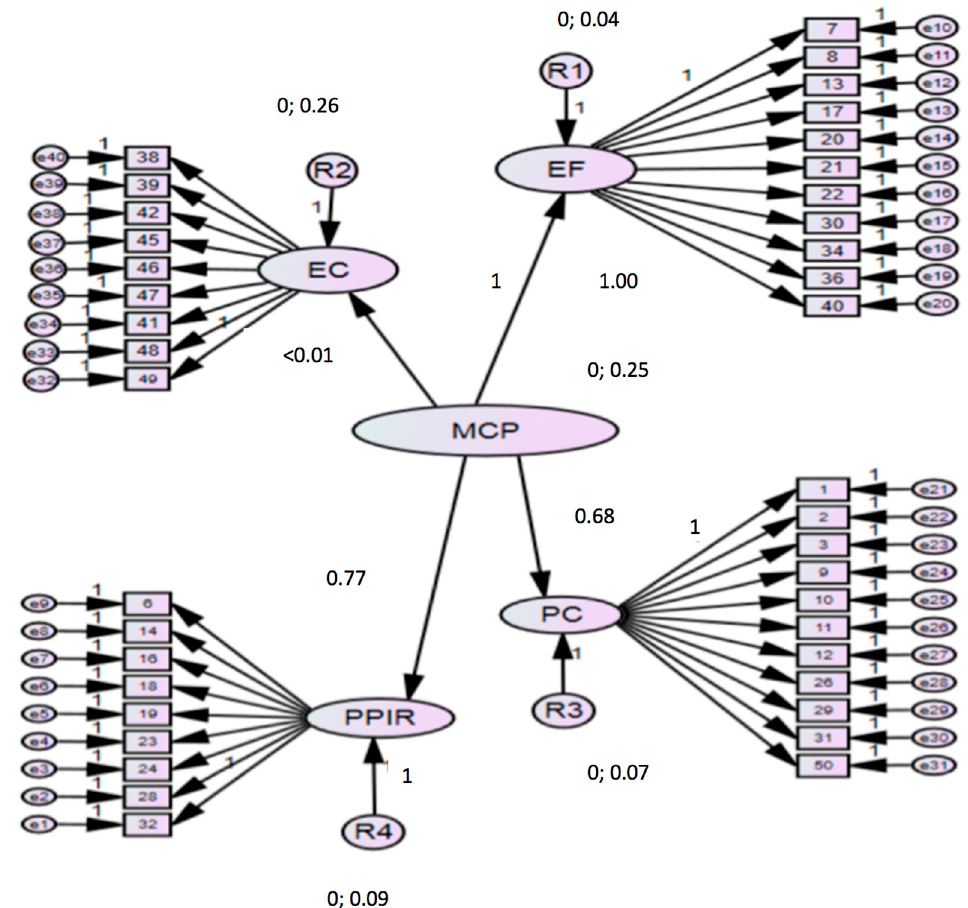
Figure 1. Model for neurotypical, specific language disorder (SLD), and autism spectrum disorder (ASD) children. χ 2 = 817.584, gl = 737.89 p = 0.020. Table 2. My Children’s Play goodness-of-fit index from the confirmatory factor analysis.